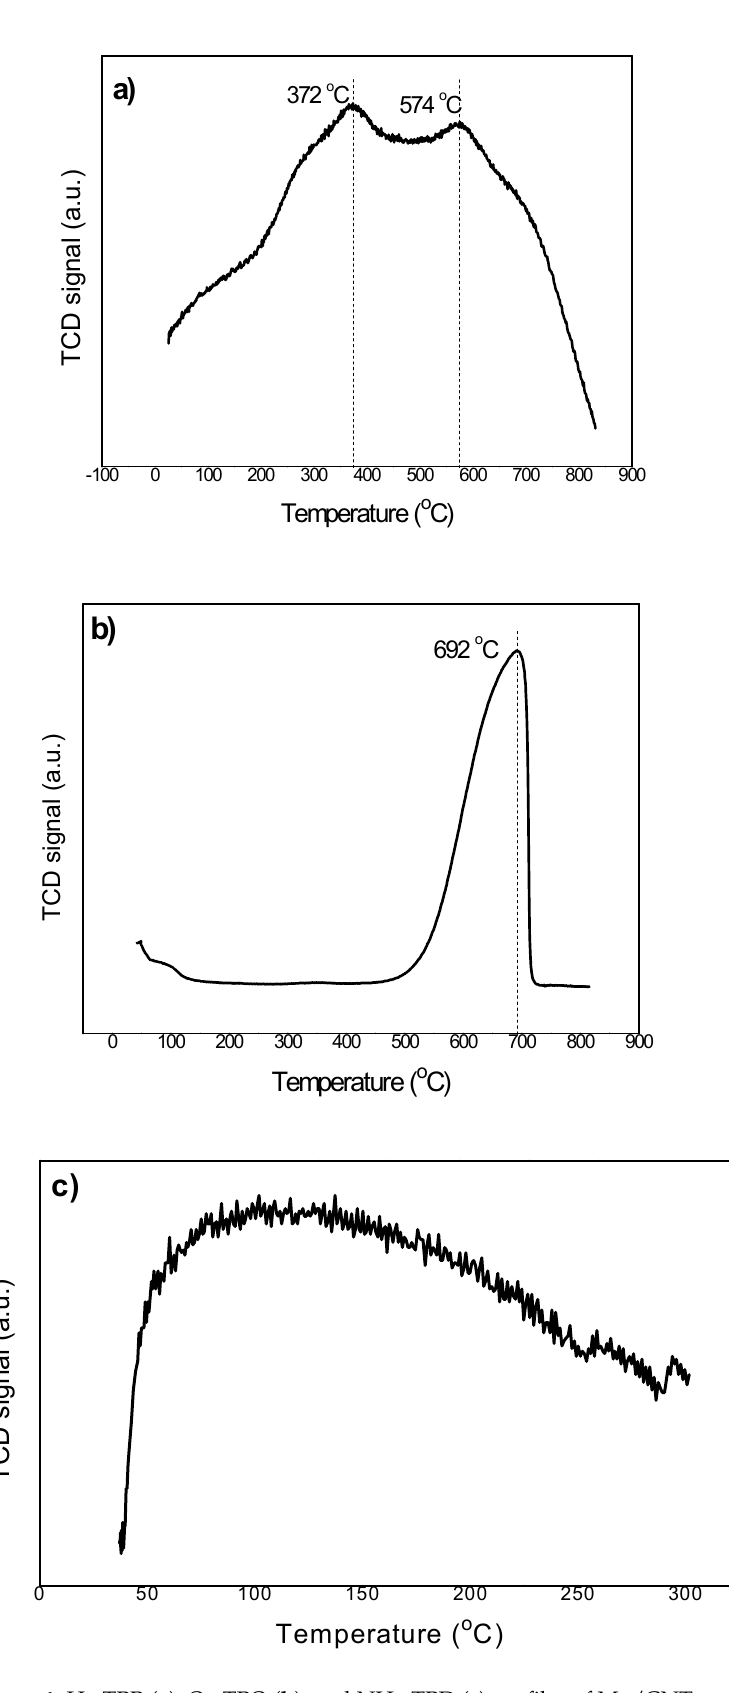
Figure 4. H 2 -TPR ( a ), O 2 -TPO ( b ), and NH 3 -TPD ( c ) profiles of Mo/CNT catalyst.